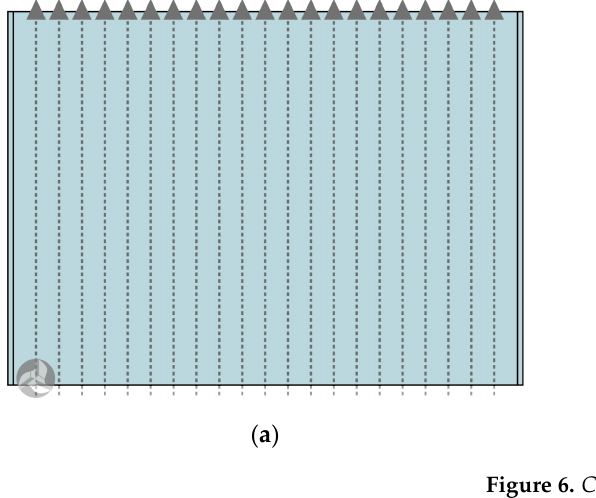
Table 3. Configuration of the Taguchi cutting parameters.